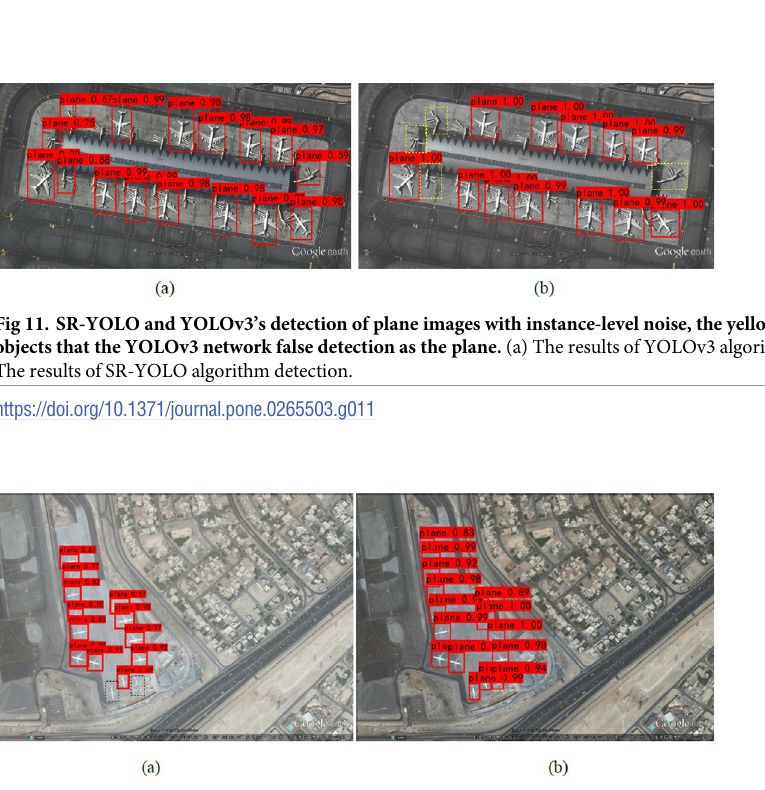
Fig 12. SR-YOLO and YOLOv3 detect plane images with cloud and fog occlusion. The black box indicates the undetected plane. (a) Results of YOLOv3 algorithm detection; (b) Results of SR-YOLO algorithm detection.